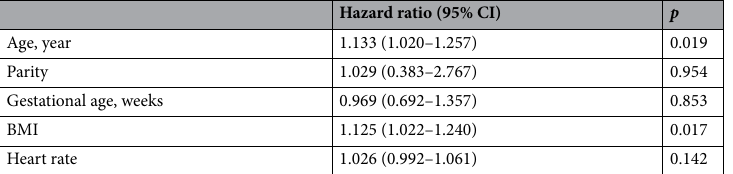
Table 4. Independent effect of parameters on the prediction of diastolic function decline (Em < 13). 95% CI 95% confidence interval, BMI body mass index.